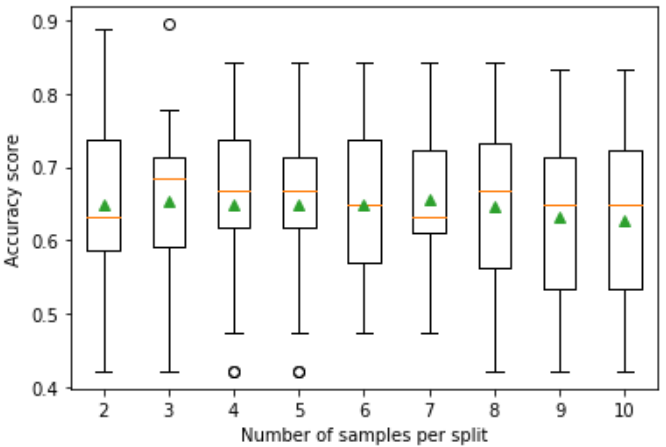
Figure 16. Ecuador: Boxplot to illustrate the mean accuracy distribution by hyper-tuning the minimum number of samples per split.